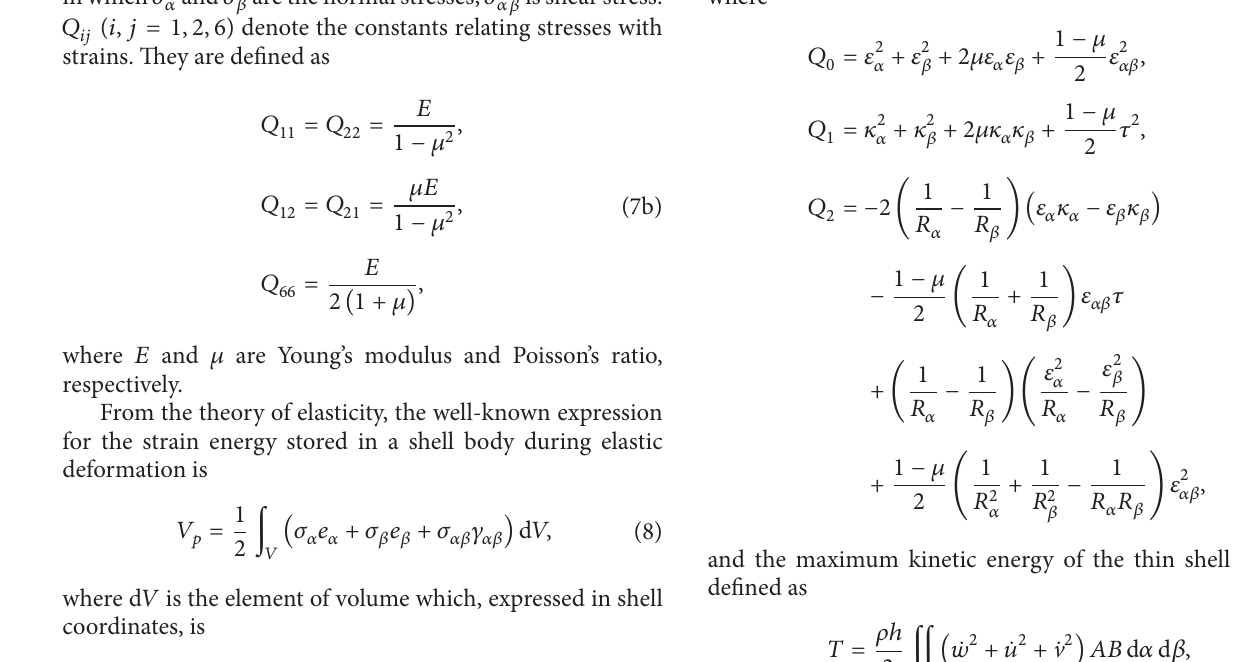
in which 𝜎 𝛼 and 𝜎 𝛽 are the normal stresses; 𝜎 𝛼 𝛽 is shear